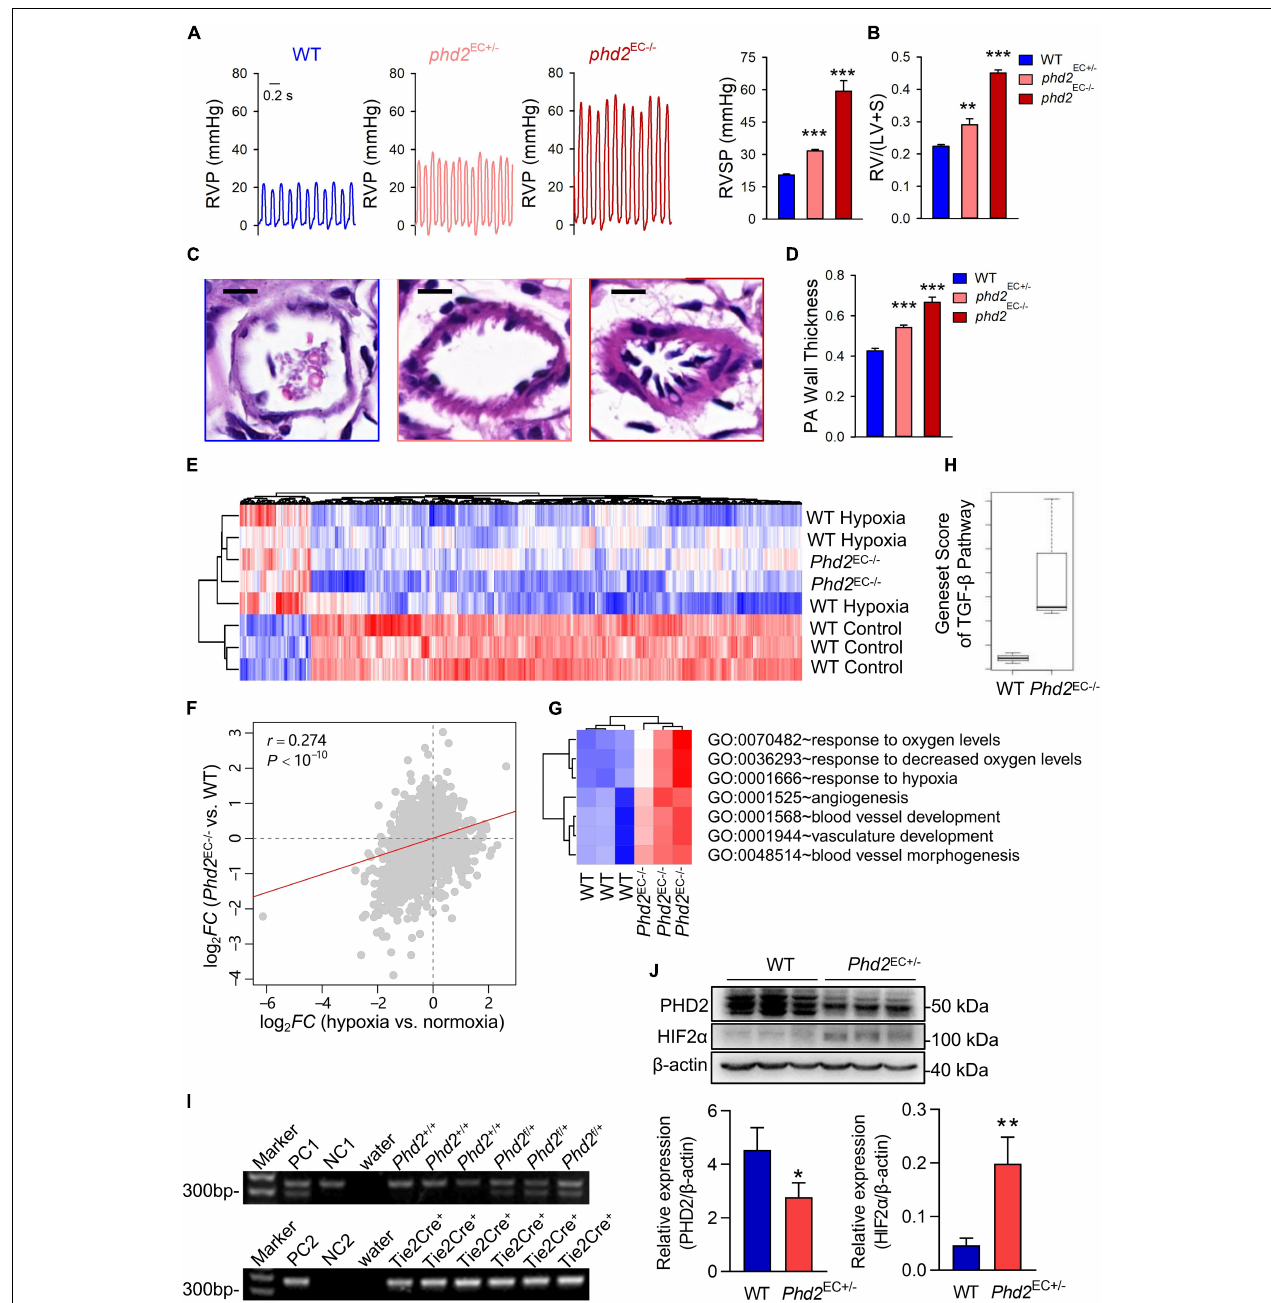
FIGURE 4 | HIF2 α -mediated GO terms involved in the development of Phd2 -KO mediated spontaneous PH. (A) A representative waveform shows RVP (left) and statistical data (right) represents peak RVSP in WT, Phd2 EC + / − and Phd2 EC - / - mice ( n = 6). Scale bars = 0.2 sec. (B) Statistical data of the RV/(LV + S) ratio shows RV hypertrophy defined by the Fulton index as a ratio [RV/(LV + S)] in WT, Phd2 EC + / − and Phd2 EC - / - mice ( n = 6). (C) Typical H & E images of pulmonary arterioles from WT, Phd2 EC + / − and Phd2 EC - / - mice. Scale bars = 10 µ m. (D) Statistical data shows PA wall thickness that generated by the ratio of wall area to total vessel area in PAs which were restricted less than 100 µ m in diameter from WT, Phd2 EC + / − or Phd2 EC - / - mice ( n = 6). (E) Expression heatmap of the genes commonly deregulated in both hypoxia and Phd2 EC - / - deficient groups. Red and blue represent relative up-regulation and down-regulation of gene expression, respectively. (F) Correlation in log 2 FC between hypoxia vs. normoxia mice ( X -axis) and Phd2 EC - / - vs. WT mice ( Y -axis) The correlation coefficient (r) and P -value were computed by Pearson correlation test. (G) Gene set score heatmap of the HIF2 α -mediated GO biological process terms in WT and Phd2 EC - / - mice. In total, seven GO terms up-regulated in Phd2 EC - / - lungs were listed. Red and blue represent relative up-regulation and down-regulation of gene expression, respectively. (H) Comparison of gene set score of the TGF- β signaling pathway between WT and Phd2 EC - / - mice. (I) Genotyping of WT and Phd2 EC + / − mice. PC1: positive control 1 ( Phd2 f / + ), PC2: positive control 2 (Tie2-Cre + / − ), NC1: negative control 1 ( Phd2 + / + ), NC2: negative control 2 (Tie2-Cre - / - ). (J) Relative expression of the PHD2 and HIF2 α in mice lung tissues detected by western blotting with β -actin as control ( n = 3). Significance levels: * P < 0.05, ** P < 0.01 and *** P < 0.001 ( t -test).